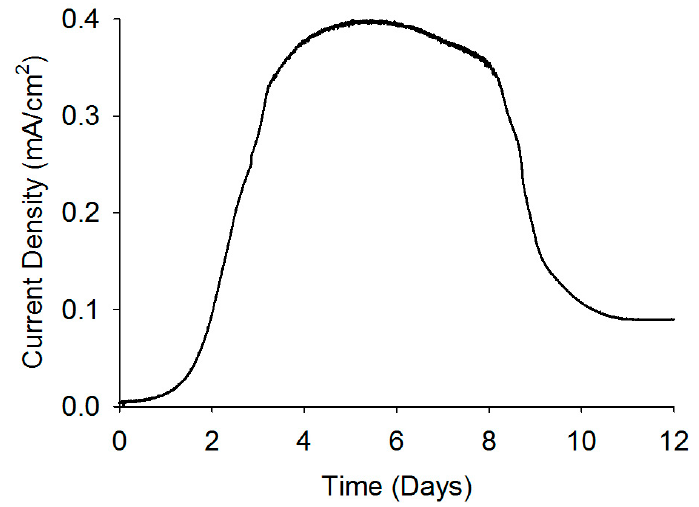
Figure 4. Current generation by the EAB through the substrate oxidation.